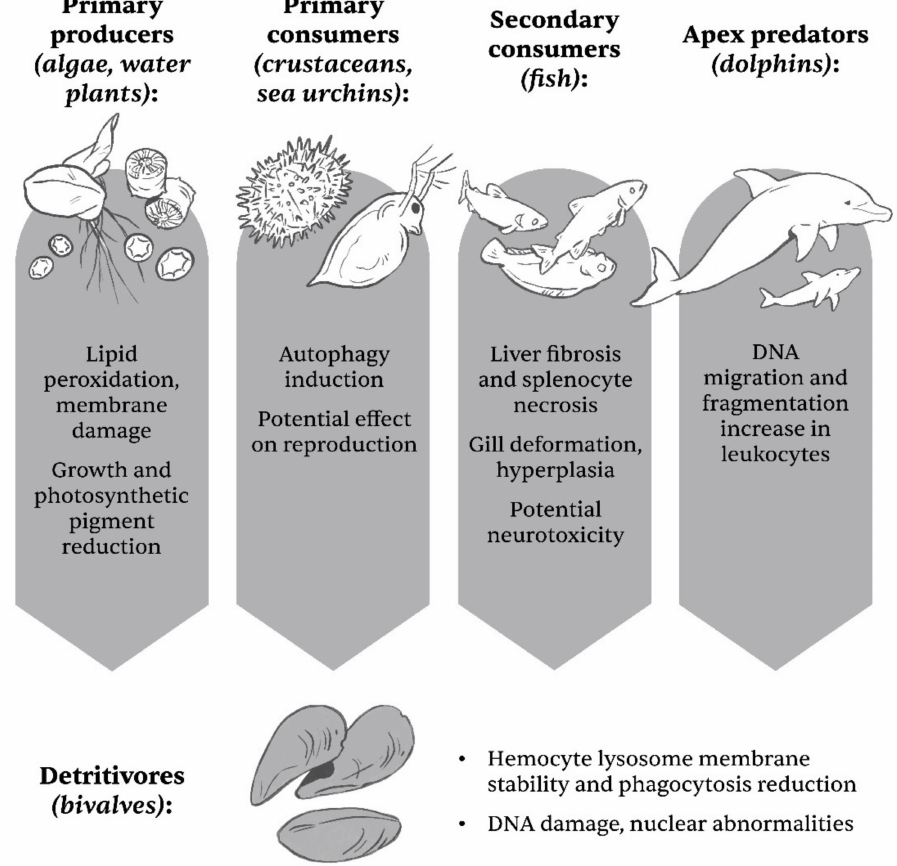
Figure 3. Some of the effects of TiO 2 NPs on various organisms consisting different trophic levels in aquatic ecosystems. Apart from bioaccumulation and biomagnification, one should not ignore the impact of potential biomass reduction from one of the rungs due to TiO 2 NPs toxicity, which could in turn affect all other levels (Illustrator: Matevž